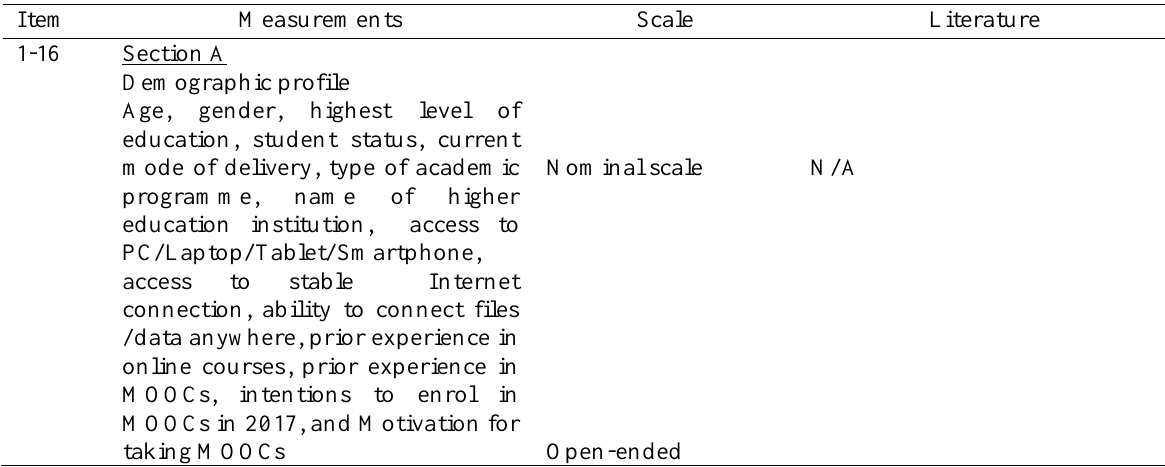
Measurement Framework of the